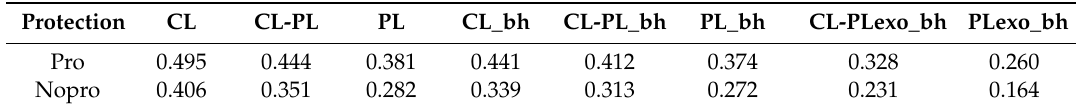
Table 10. Results of the 3 FMU scenarios at T 150 .